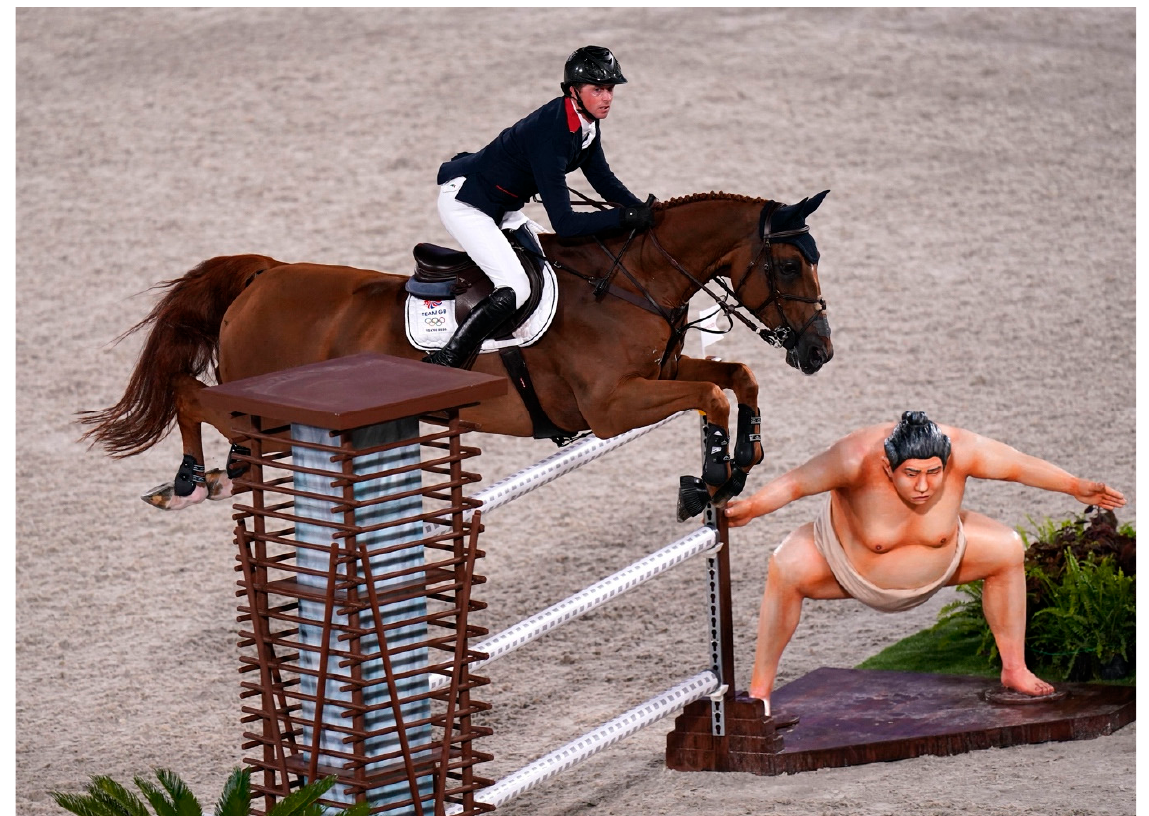
Figure 6. Realistic sumo statue on the equestrian course at the Tokyo 2020 Olympic Games, Japan, 4 August 2021. Reproduced with permission from Adam Davy/PA Images; published by Alamy Stock Photo (image no. 2GCDM63).